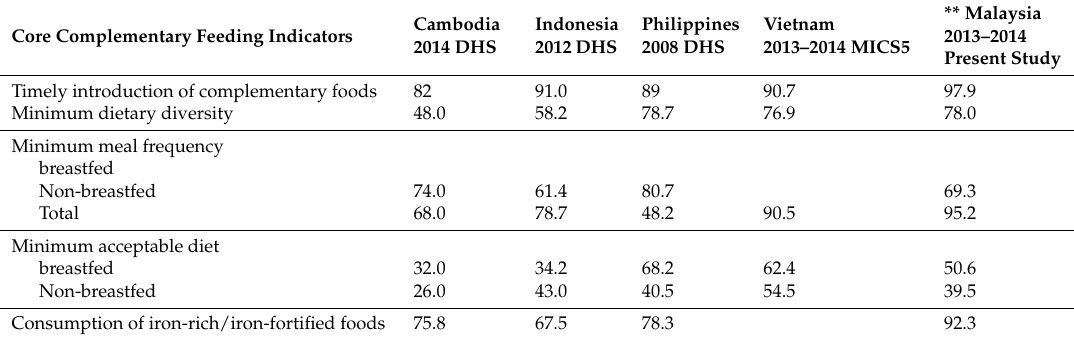
Table 5. Comparison of WHO IYCF practices among countries in Southeast Asia *.